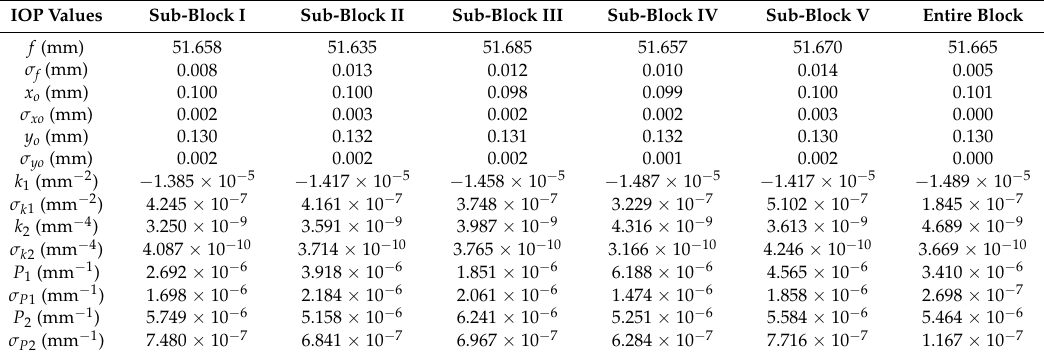
Table 2. Estimated interior orientation parameters (IOP) by in situ camera